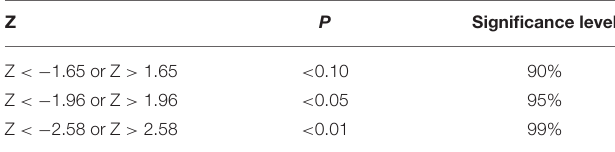
TABLE 1 | Z- and P -values, and significance level.